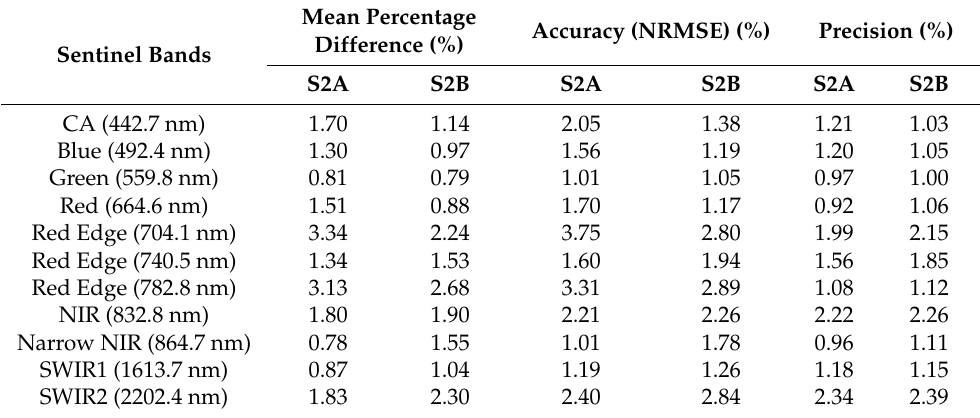
Table 7. Systematic offsets and random uncertainties between absolute calibration model predictions and Sentinel MSI